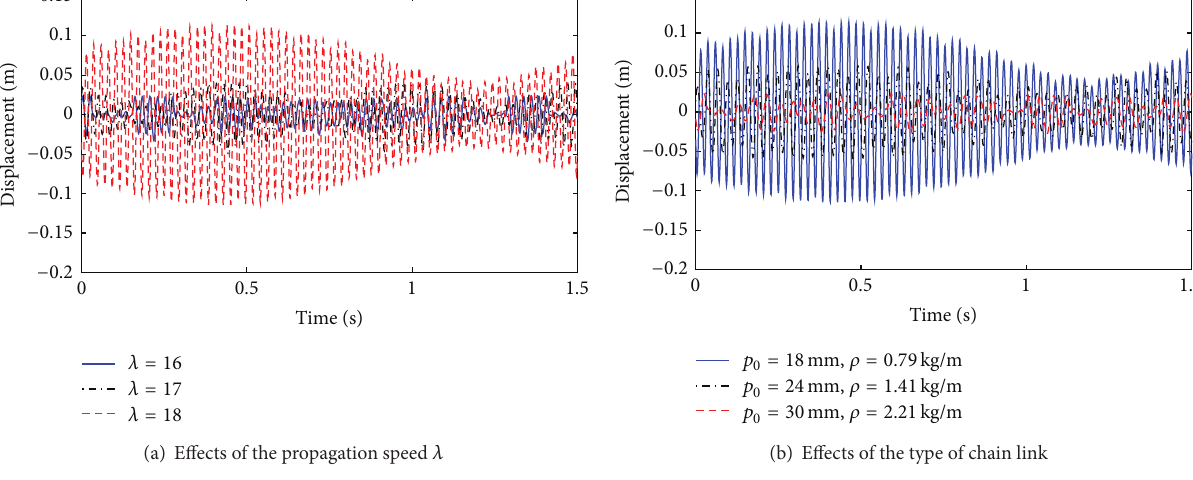
Figure 6: The total contribution of both head and end boundary conditions with polygonal action.